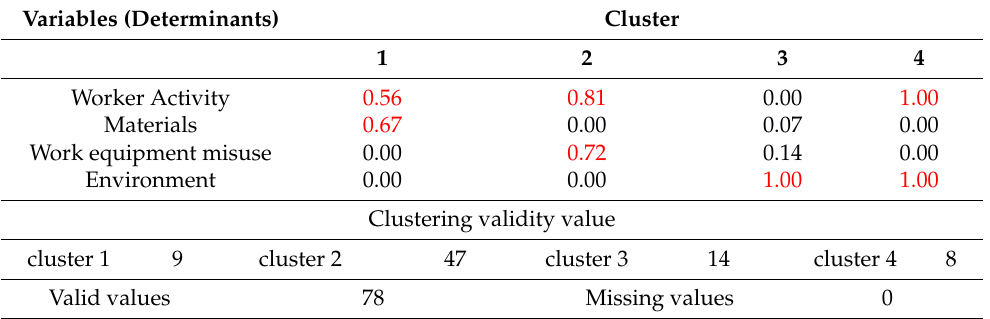
Table 10. Results of the four-cluster